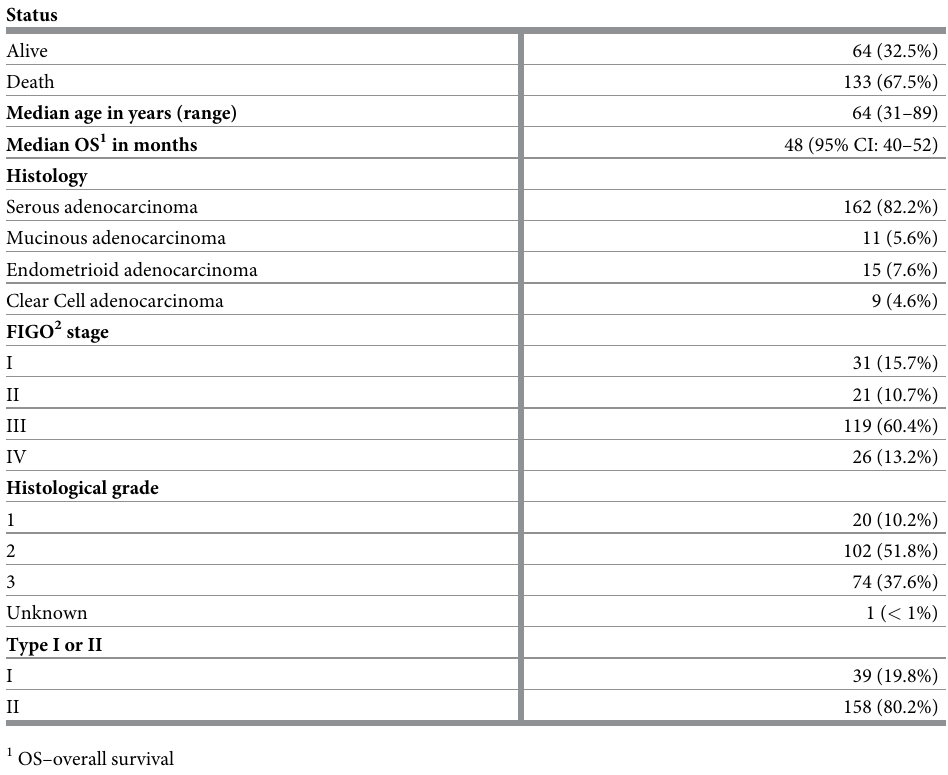
Table 1. Clinicopathological characteristics of 197 epithelial ovarian cancer